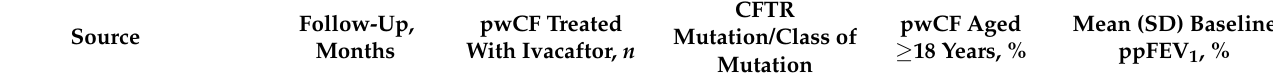
Table 1. Study and patient